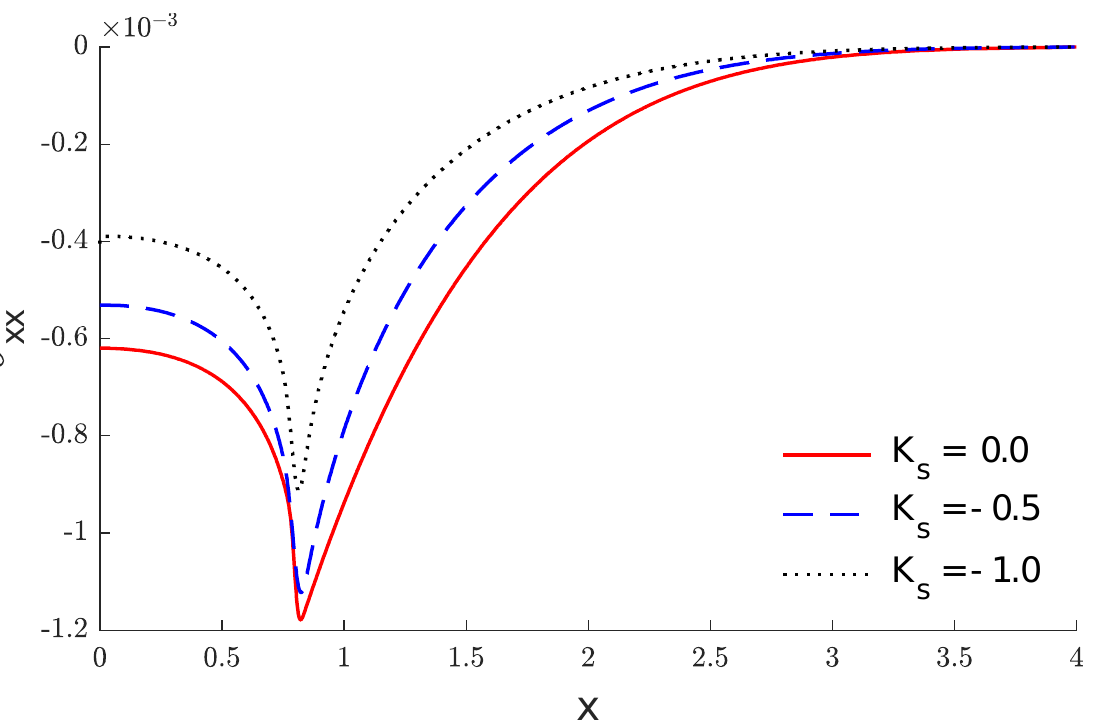
Figure 4. The stress variations under various values of 𝐾 𝑠 .